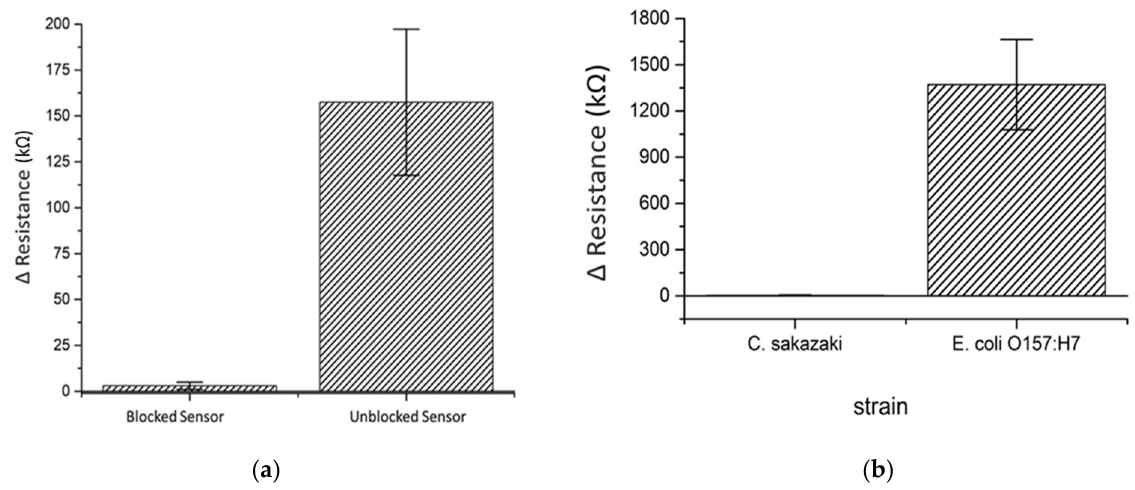
Figure 5. Relative change in sensor resistivity (blocked and unblocked) after incubation with C. sakazakii ( a ), and relative change in sensors resistivity of C. sakazakii and E. coli O157:H7 on E. coli O157:H7 nanosensor ( b ).